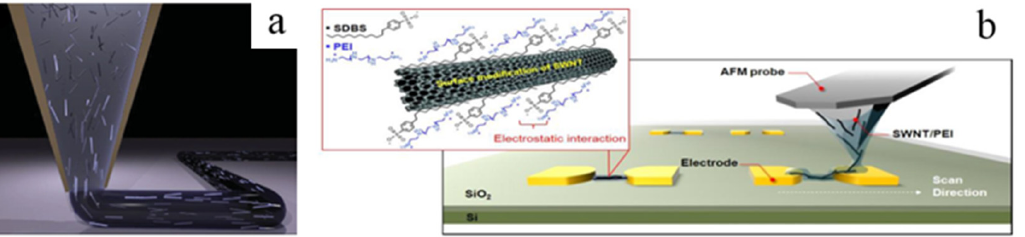
Figure 18. ( a ) Schematic of the alignment of high aspect ratio fillers during the process of extrusion.